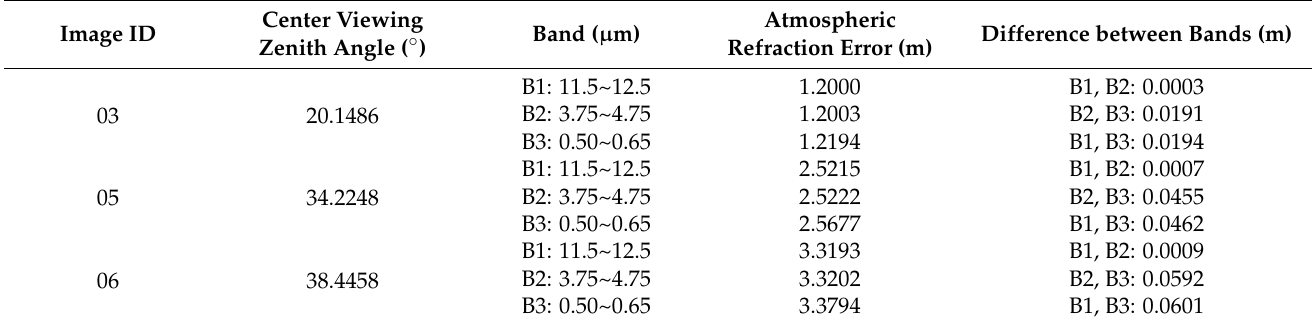
Table 3. Atmospheric refraction error of different bands of the proposed SARCM.